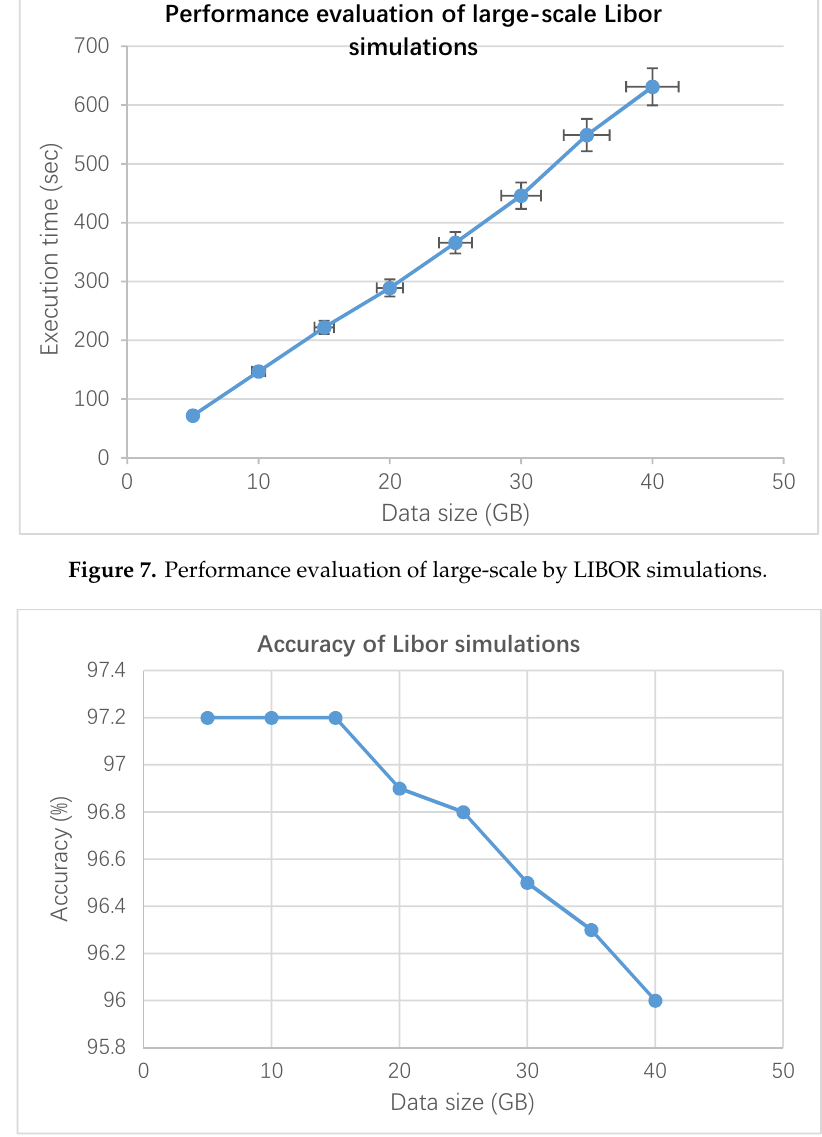
Figure 8. Accuracy of LIBOR simulations by comparing our predicted values and actual values.